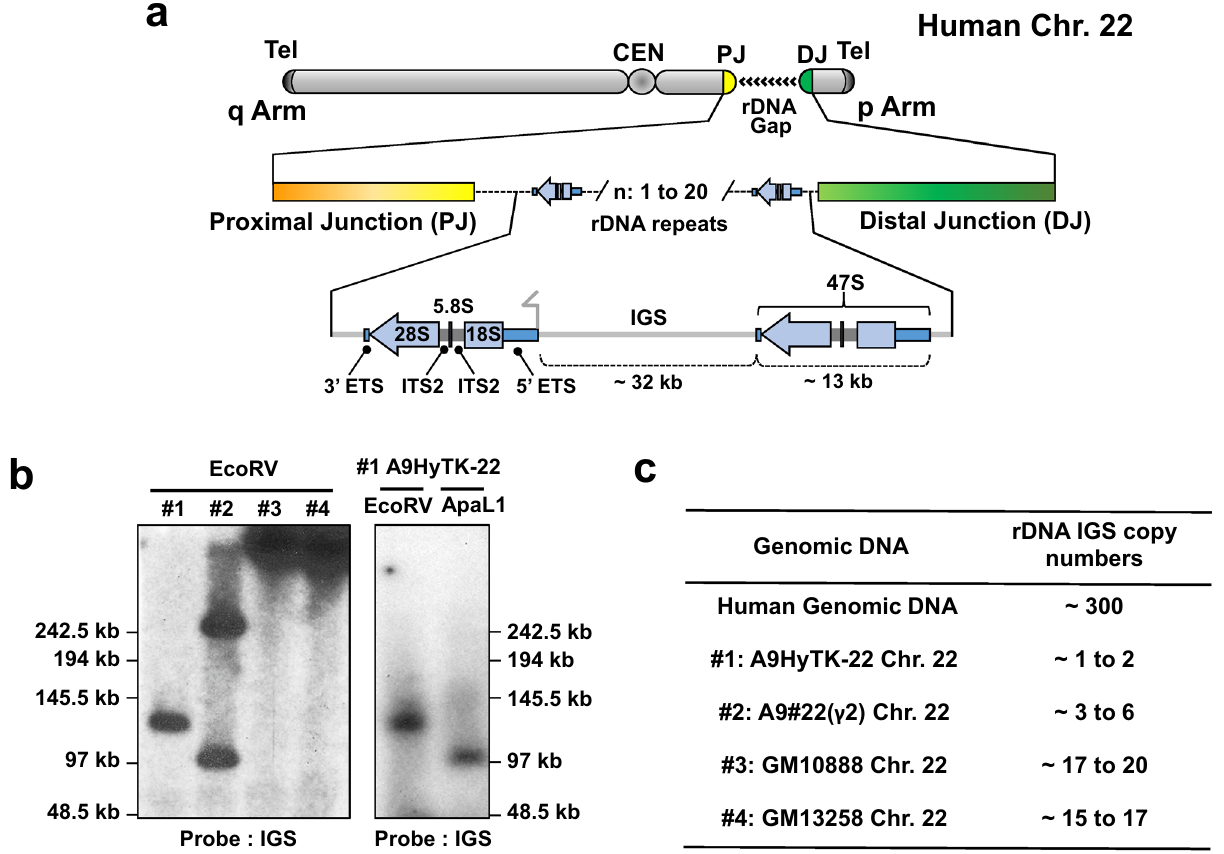
Figure 1. Schematic representation of the acrocentric human chromosome 22. ( A ) Scheme of the chromosome 22 with the rDNA portion and proximal (PJ) and distal (DJ) junction sequences. The number of rDNA units (n) on chromosome 22 varies from 1 to 20. The ~ 13 kb transcribed human 47S rDNA region shown as a blue arrow. Each rDNA unit is composed of the transcribed region encoding 47S rRNA (5 ′ ETS, 18S, ITS1, 5.8S, ITS2, 28S and 3 ′ ETS) and a ∼ 32 kb IGS (intergenic spacer sequence). ( B ) Southern blot analysis of four mouse/human hybrid cell lines containing human chromosome 22. After EcoRV digestion of DNA isolated from each hybrid cell line, the rDNA repeats were detected with a probe specific to the rDNA intergenic spacer (IGS). Southern blot analysis of the A9HyTk-22 mouse/human cell line was also performed after ApaLI endonuclease digestion. ( C ) A copy number of the rDNA repeats in each hybrid cell line was estimated by quantitative real-time PCR (qPCR) with a set of the primers specific to the